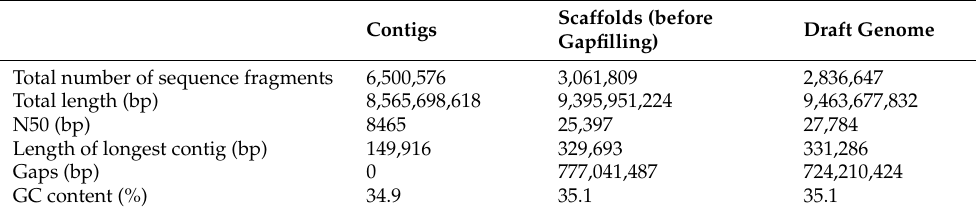
Figure 2. Flowchart of genome assembly and gene prediction. The paired-end (PE) reads and Miseq (MS) reads were subjected to contig assembly by a three-step process, including “pre-assembly” using PANDAseq, “contig assembly” using SOAPdenovo, and “clean-up & merging” using BLASTN. The PacBio (PB) reads were subjected to hybrid assembly using SSPACE-LONGREAD, generating pre-scaffolds. Then, the mate-pair (MP) reads were subjected to scaffold generation by a four-step process, including “read selection” using bowtie2, “scaffolding” using SSPACE-STANDARD, “gapfilling” using Gapfiller and TGS-Gapcloser, and “polishing” using POLCA. These processes yielded the complete draft genome. The coding sequences in the draft genome were then annotated by a four-step process, including “Training data generation” using BUSCO, “Gene prediction” using AUGUSTUS, “TE search” (TE, transposable element) using hmmpfam, and “Gene annotation” using InterProScan and Blast2GO. Table 2. Statistics of genome